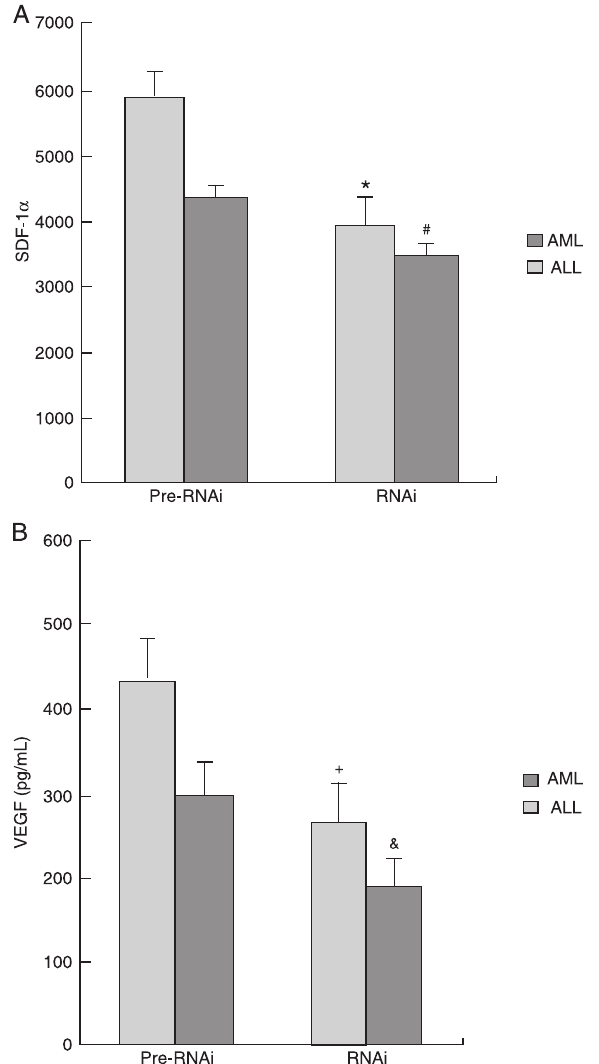
Figure 5. Changes in VEGF and SDF-1 protein expression after HIF-1α silencing in stromal cells. A , SDF-1α expression in strom - al cells decreased in both the AML (*P < 0.01, Pre-RNAi vs RNAi group) and ALL ( # P < 0.01, Pre-RNAi vs RNAi group) groups af - ter HIF-1α silencing. B , VEGF protein expression in stromal cells decreased in both the AML ( + P < 0.01, Pre-RNAi vs RNAi group) and ALL ( & P < 0.01, Pre-RNAi vs RNAi group) groups after HIF- 1α silencing. The t -test was used for statistical analyses. VEGF = vascular endothelial growth factor; SDF-1 = stromal cell-derived factor-1; HIF-1α = hypoxia-inducible factor-1; AML = acute my - eloblastic leukemia; ALL = acute lymphoblastic